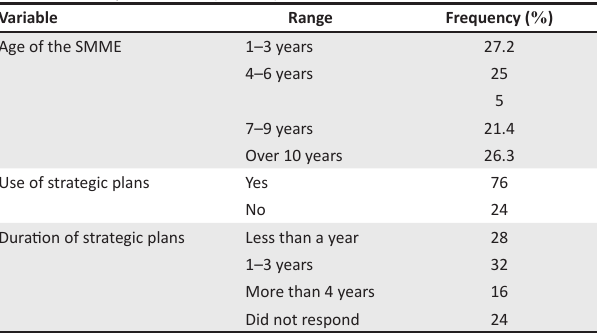
TABLE 2: Descriptive results ( n = 225).